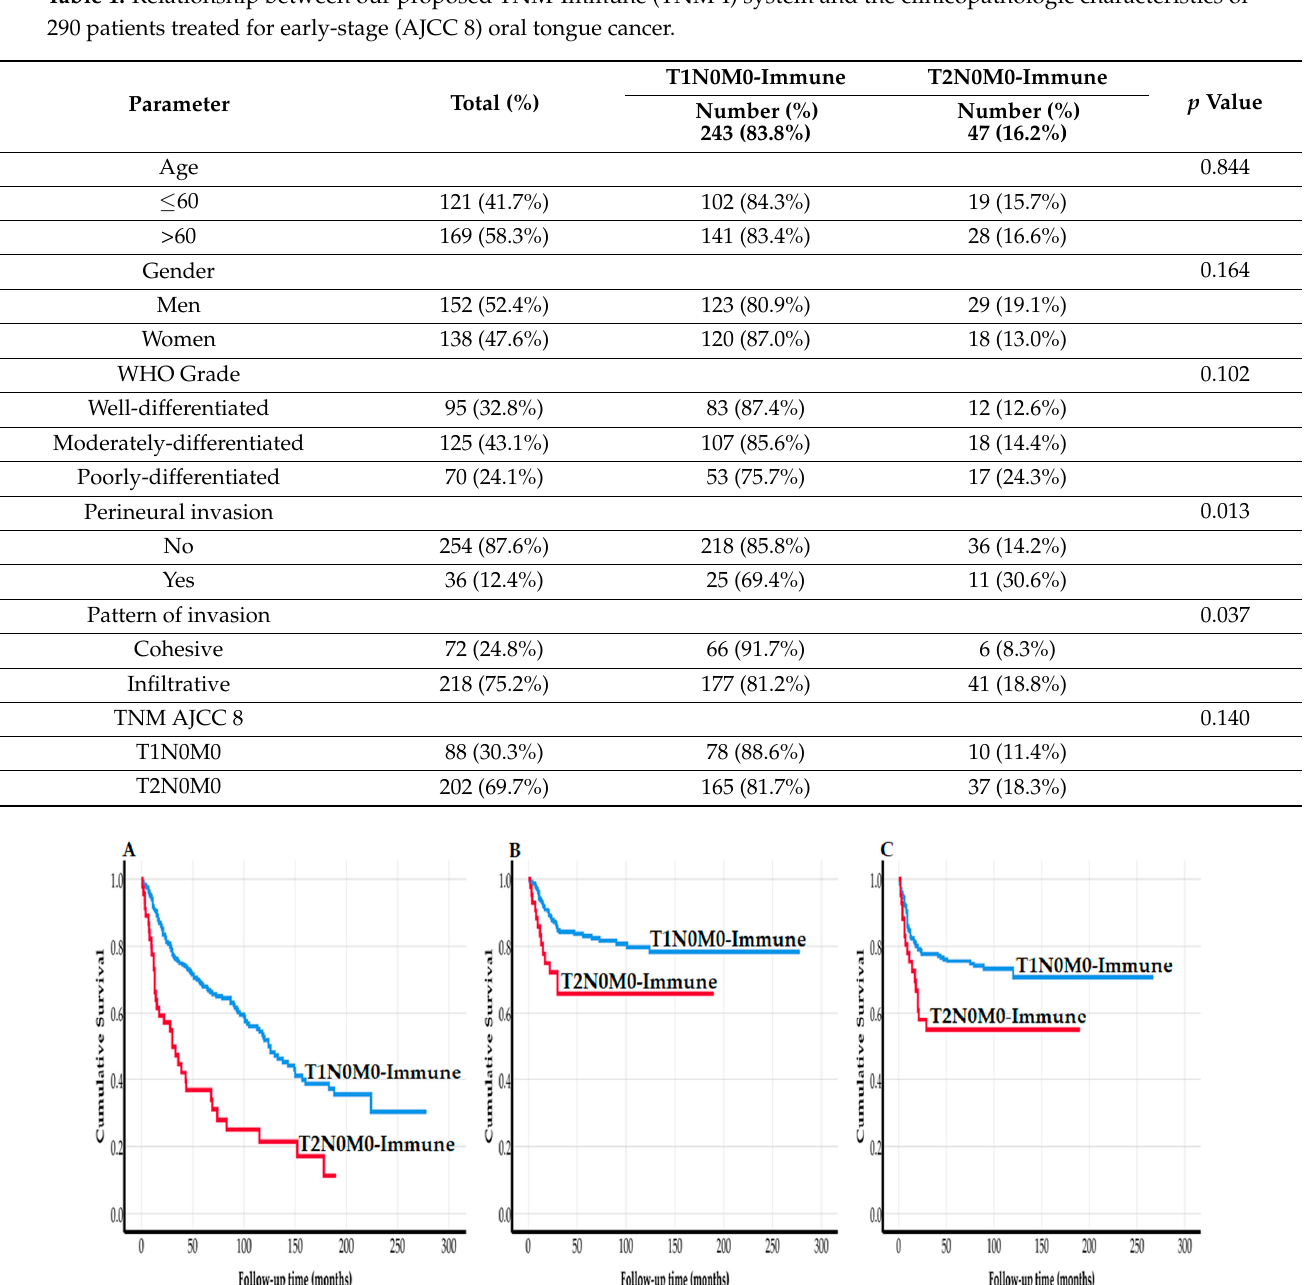
Figure 1. Correlation between TNM-Immune staging system and overall survival (( A ): p < 0.001), disease-specific survival (( B ): p = 0.010), and disease-free survival (( C ): p = 0.012) in 290 patients treated for early oral tongue cancer. Table 2. Overall survival, disease-specific survival and disease-free survival analyses of 290 patients of early oral tongue cancer (AJCC 8). The survival analyses include the routinely evaluated classification (TNM AJCC 8 and WHO Grading) and our proposed TNM-immune classification.